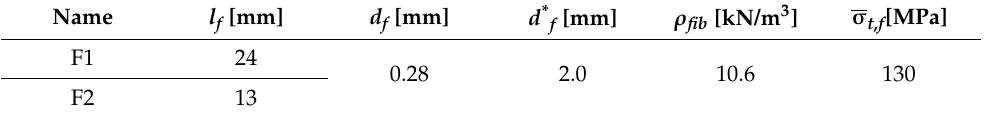
Table 1. Geometry and mechanical properties of the Sisal fibers used in the experiments.